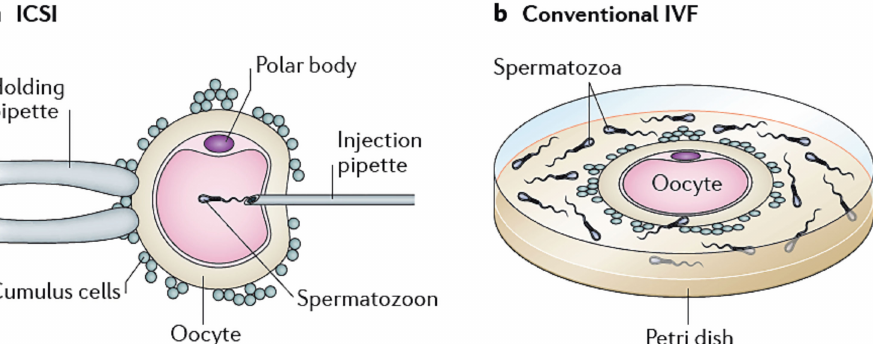
Figure 3. Assisted fertilization methods. ( a ) Intracytoplasmic sperm injection (ICSI) involves the injection of a single spermatozoon into an oocyte cytoplasm using a glass micropipette. ( b ) Standard in vitro fertilization (IVF), where oocytes are incubated with sperm in a Petri dish, and the sperm cell fertilizes the oocyte naturally. Reprint with permission from Ref [43]. Table 3. Studies that examined epigenetic modifications in infertile males. Adapted with permission from Ref